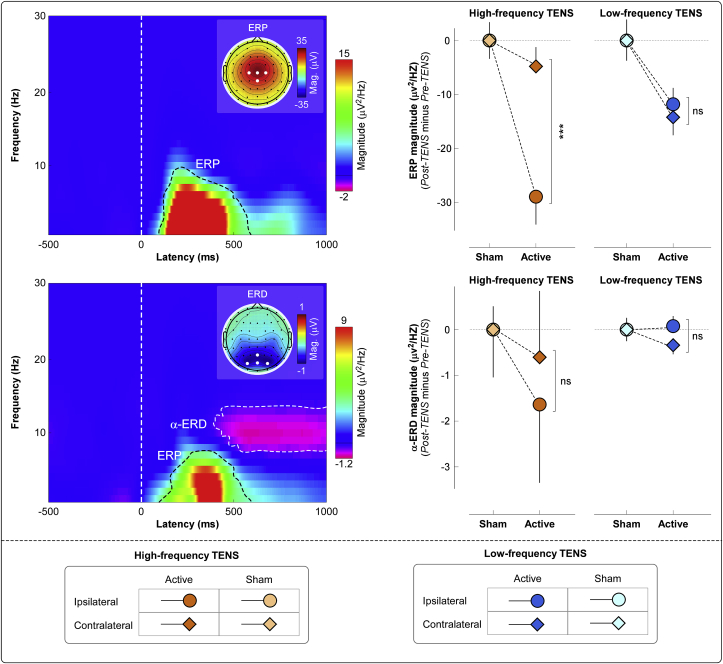
Group-level laser-elicited time-frequency responses. Left panel: Group-level time-frequency distributions and scalp topographies of ERP and α-ERD responses, averaged across experimental groups and conditions. The color scale represents the increase or decrease of the oscillatory magnitude, relative to a prestimulus interval (−400 to −100 ms). The displayed time-frequency distributions contain both phase-locked (ERP: 100–500 ms, 1–10 Hz) and non-phase-locked brain responses (α-ERD: 500–1000 ms, 8–12 Hz), highlighted by the dashed lines. ERP and α-ERD magnitudes were measured at central (top left) and parietal-occipital (bottom left) electrodes respectively. Electrodes showing the maximal response for each time-frequency feature are highlighted in white in the scalp topographies. Right panel: The effect of active TENS on the magnitude of the ERP (top right) and α-ERD response (bottom right) was expressed as difference between Pre-TENS and Post-TENS sessions (Post-TENS minus Pre-TENS, normalized by subtracting the respective sham data for displaying purpose; statistical results from non-normalized data are reported in the main text). Data are mean ± SEM.